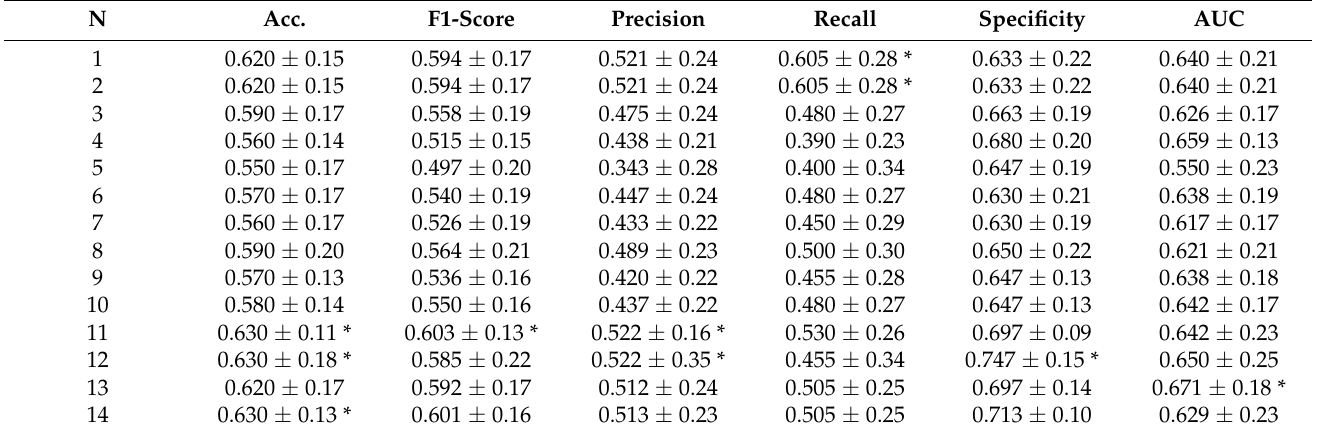
* The maximum value of each feature set; AUC, area under the receiver operating characteristic curve; Acc., accuracy; N, number of selected features, which has highest p -value by chi-square test. Table 6. Classification results for the XGBoost